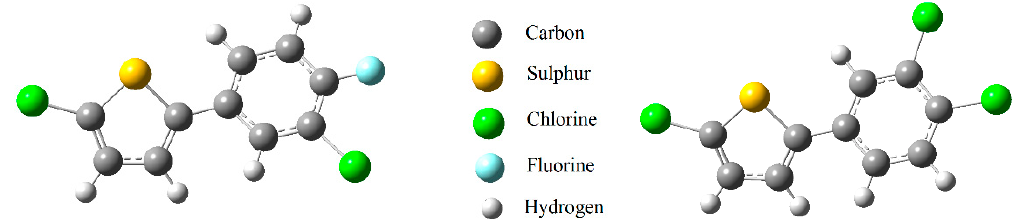
Figure 5. Optimized geometries of 2d and 2f at B3LYP/6-31G (d, p) level of DFT.